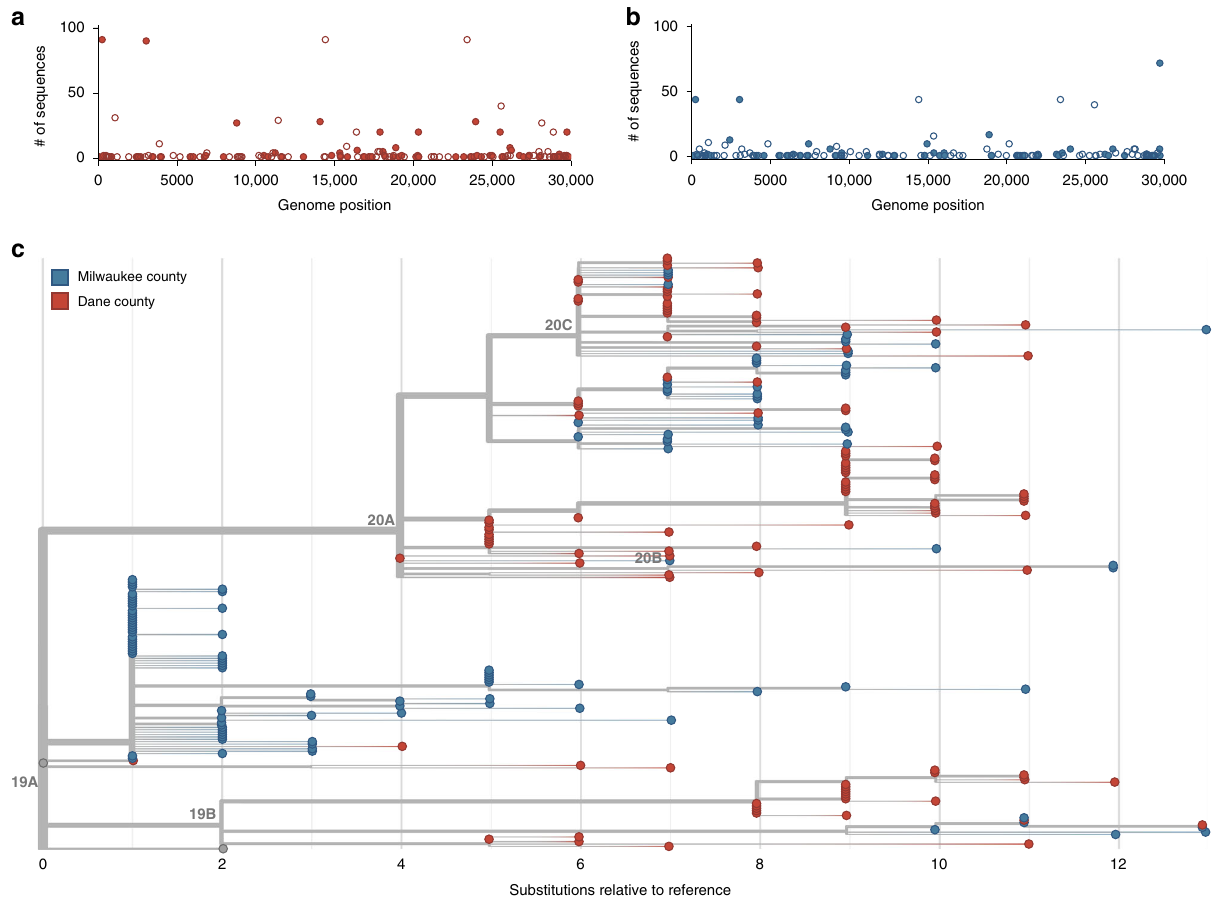
Fig. 2 Characterizing consensus-level variants and sequence divergence among Dane and Milwaukee county sequences. Single-nucleotide variants (SNVs) are annotated relative to the initial Wuhan SARS-CoV-2 reference (Genbank: MN908947.3). a Frequency of consensus SNVs among the Dane county sequences (red). b Frequency of consensus SNVs among the Milwaukee county sequences (blue). Open symbols denote synonymous or intergenic SNVs and closed symbols denote nonsynonymous SNVs. c A divergence-based phylogenetic tree built using Nextstrain tools for the 122 Dane county (red) and 125 Milwaukee county (blue) sequences. Wisconsin samples are rooted against Wuhan-Hu-1/2019 and Wuhan/WH01/2019. Source data to replicate this fi gure can be found in the Source Data fi